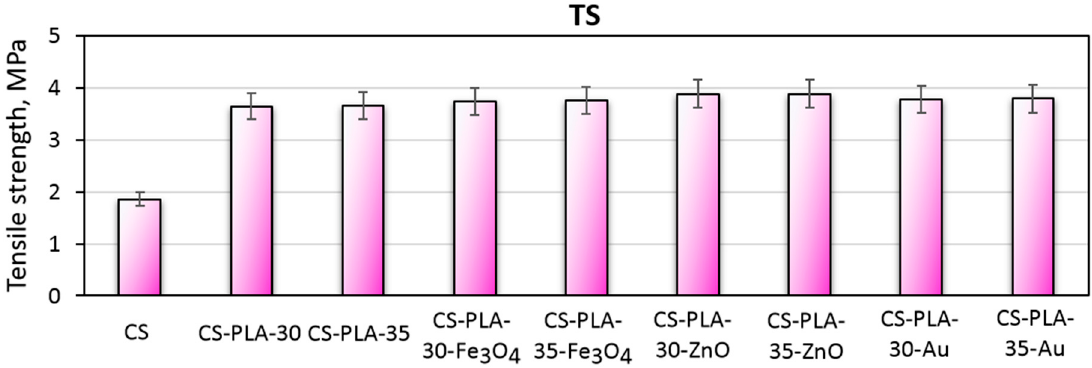
Figure 6. Tensile strength of the prepared scaffolds.